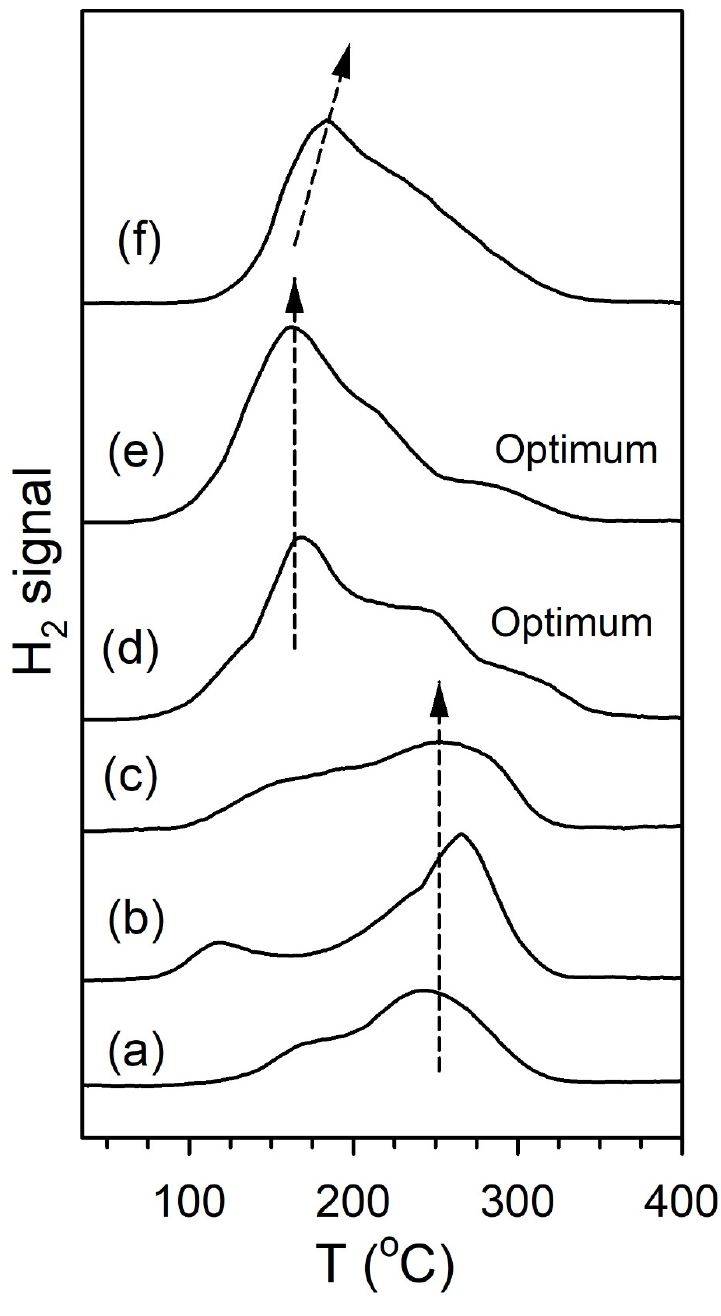
Figure 10. TP-reaction-MS of adsorbed formaldehyde/H 2 O, including ( a ) 2%Pt/m-ZrO 2 , and the same with ( b ) 0.5%Na, ( c ) 1%Na, ( d ) 1.8%Na, ( e ) 2.5%Na, and ( f ) 5%Na.